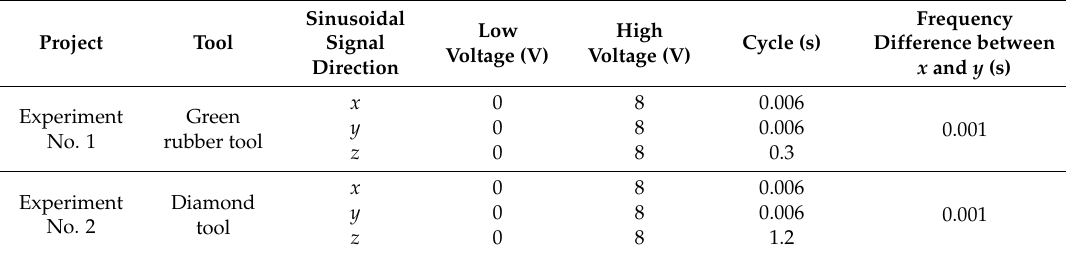
Table 3. Experimental signal parameters.